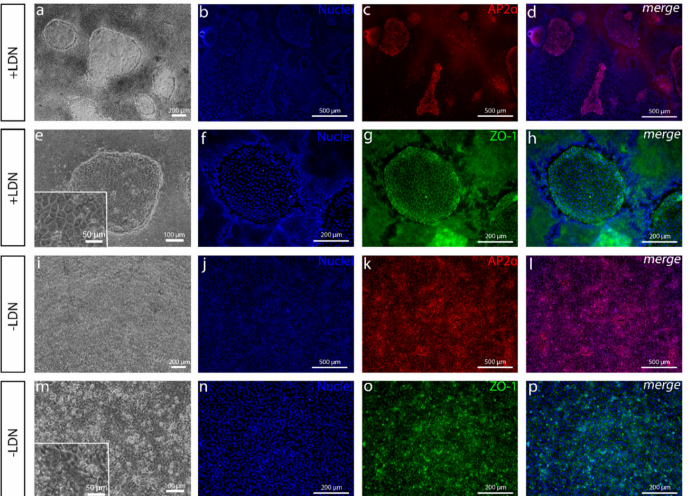
Figure 3. Comparison of cell cultures with or without BMP inhibition. ( a , e – p ) After 8 days and ( b – d ) 13 days of differentiation, ( a , e ), phase contrast microscope images and ( b – d , f – h ) immunofluorescence images of cell cultures with pathway inhibitor LDN193189 (LDN) show ( b – d ) the AP2 α -positive polygonal cell colonies where ( f – h ) zona occludens-1 (ZO-1) is localized in tight junctions surrounded by a thick cell mass. ( i – p ) Cell cultures without LDN show that ( i , m ) the thick cell mass is absent, and ( j – l ) AP2 α is positive for all the cells. ( n – p ) ZO-1 is in tight junctions as well, but the cells are less polygonal. Data conducted with the Regea08/017 hESC line. Scale bars: ( a , f – i , n – p ) 200 µ m, ( b – d , j – l ) 500 µ m, ( e , m ) 100 µ m and ( e , m magnified images) 50 µ